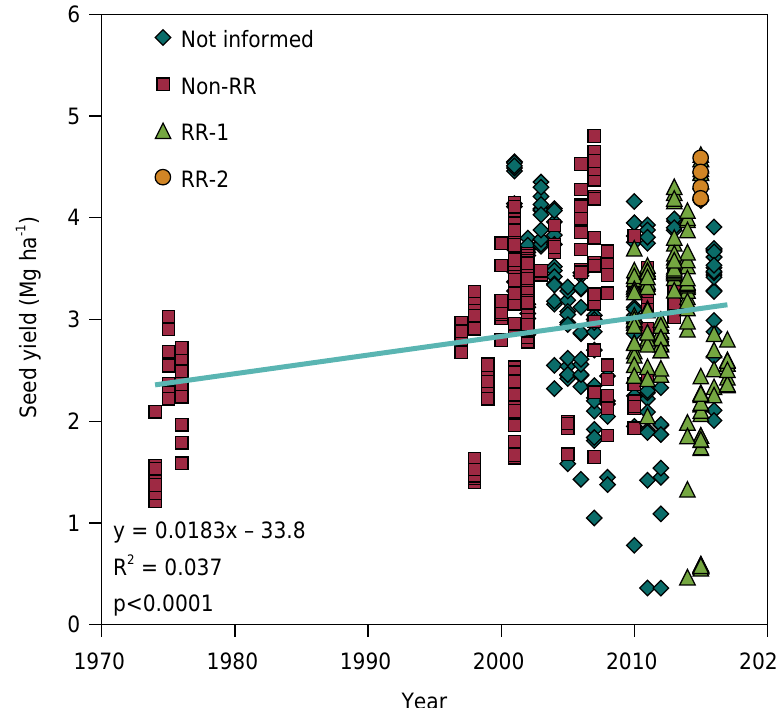
Figure 1. Time trend (1974 to 2019) for soybean seed yield. Number of field observations for seed yield = 615. Solid blue line represents a positive